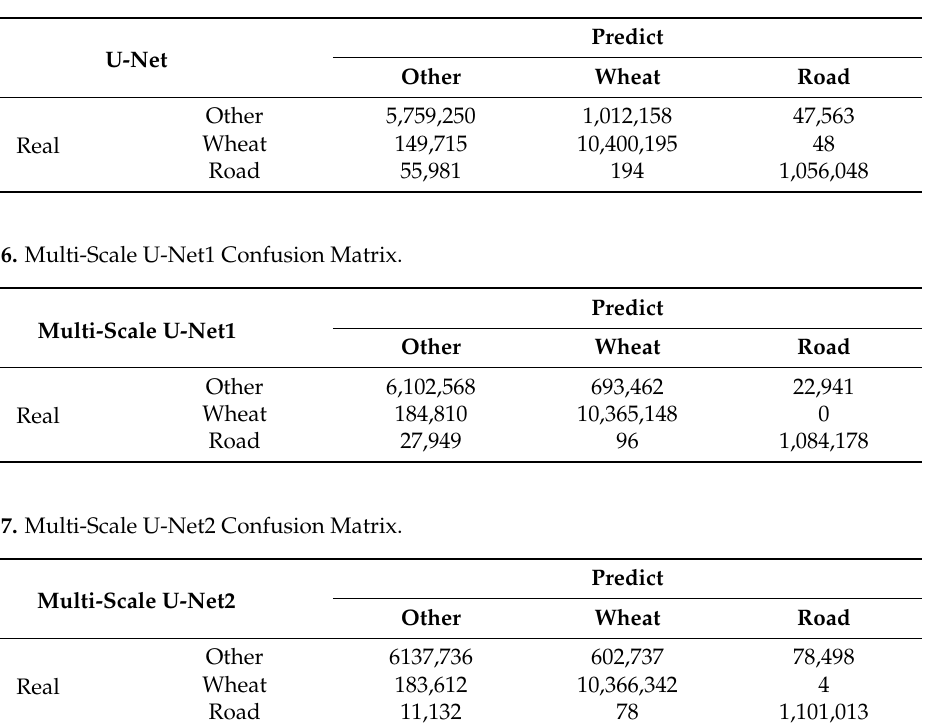
Table 5. U-Net Confusion Matrix.